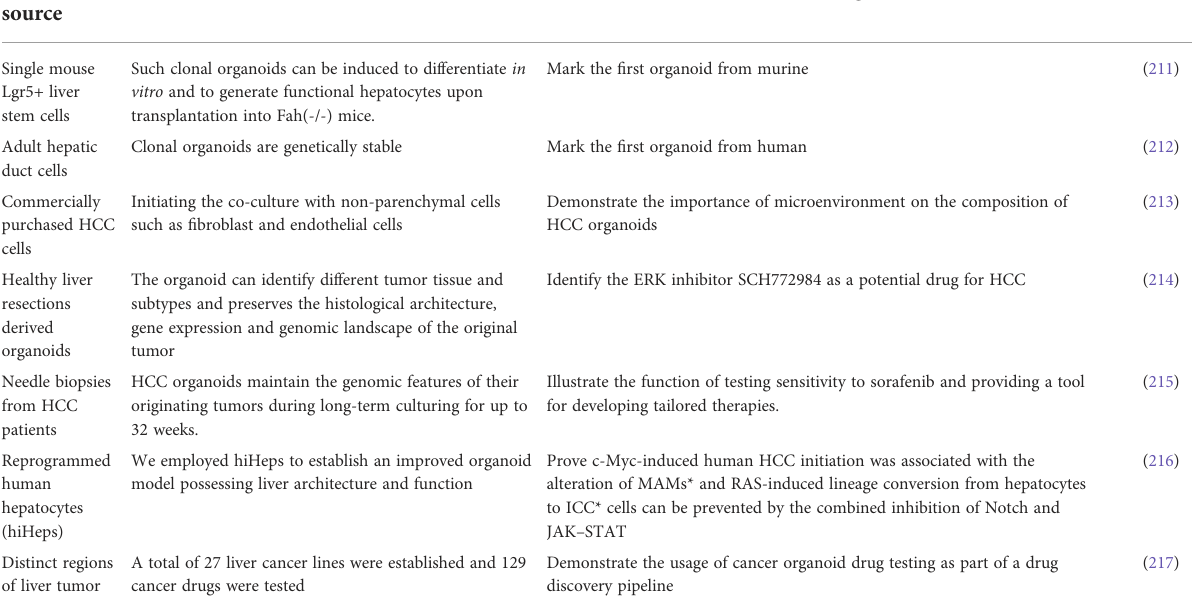
TABLE 4 The maturation process of hepatocellular organoid development. Cellular